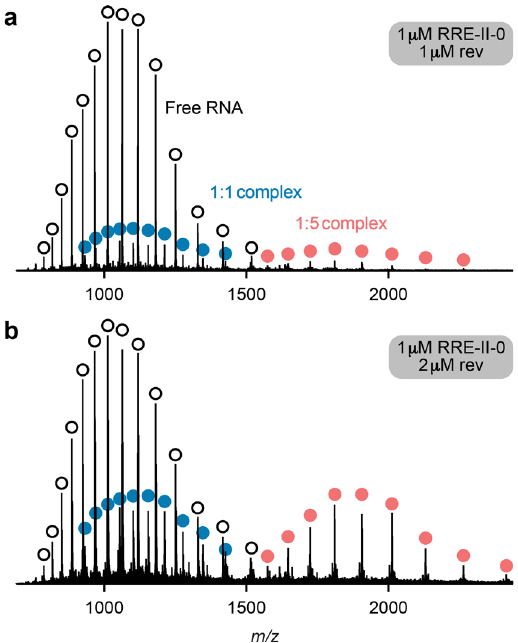
Fig. 5 RRE-II-0/rev complex stoichiometry probed by native MS. ESI spectra of 1 µ M RRE-II-0 RNA solutions in 9:1 H 2 O/CH 3 OH with ~1 mM piperidine (pH ~8.1) and a 1 µ M and b 2 µ M rev peptide (~10 min incubation time) show signals of free RNA (open circles), 1:1 complex (blue circles), and 1:5 complex (red